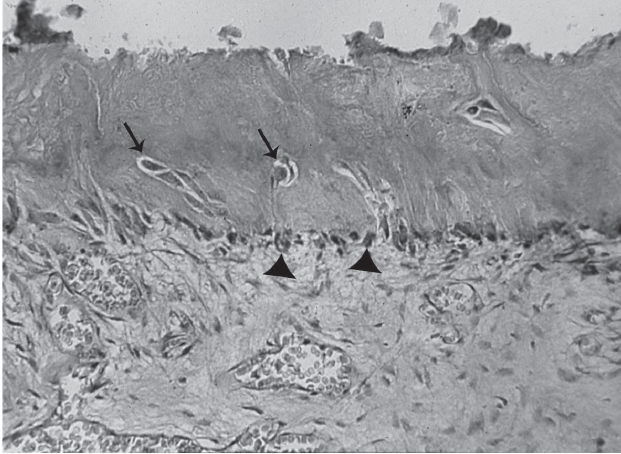
Fig. 5 - (group III; 30th day) - Hard tissue barrier with embedded cells (arrows). Newly-formed odontoblast-like cells organized in layer (arrowheads) and moderate deposition of dentin matrix. Hematoxylin-eosin, original magnification